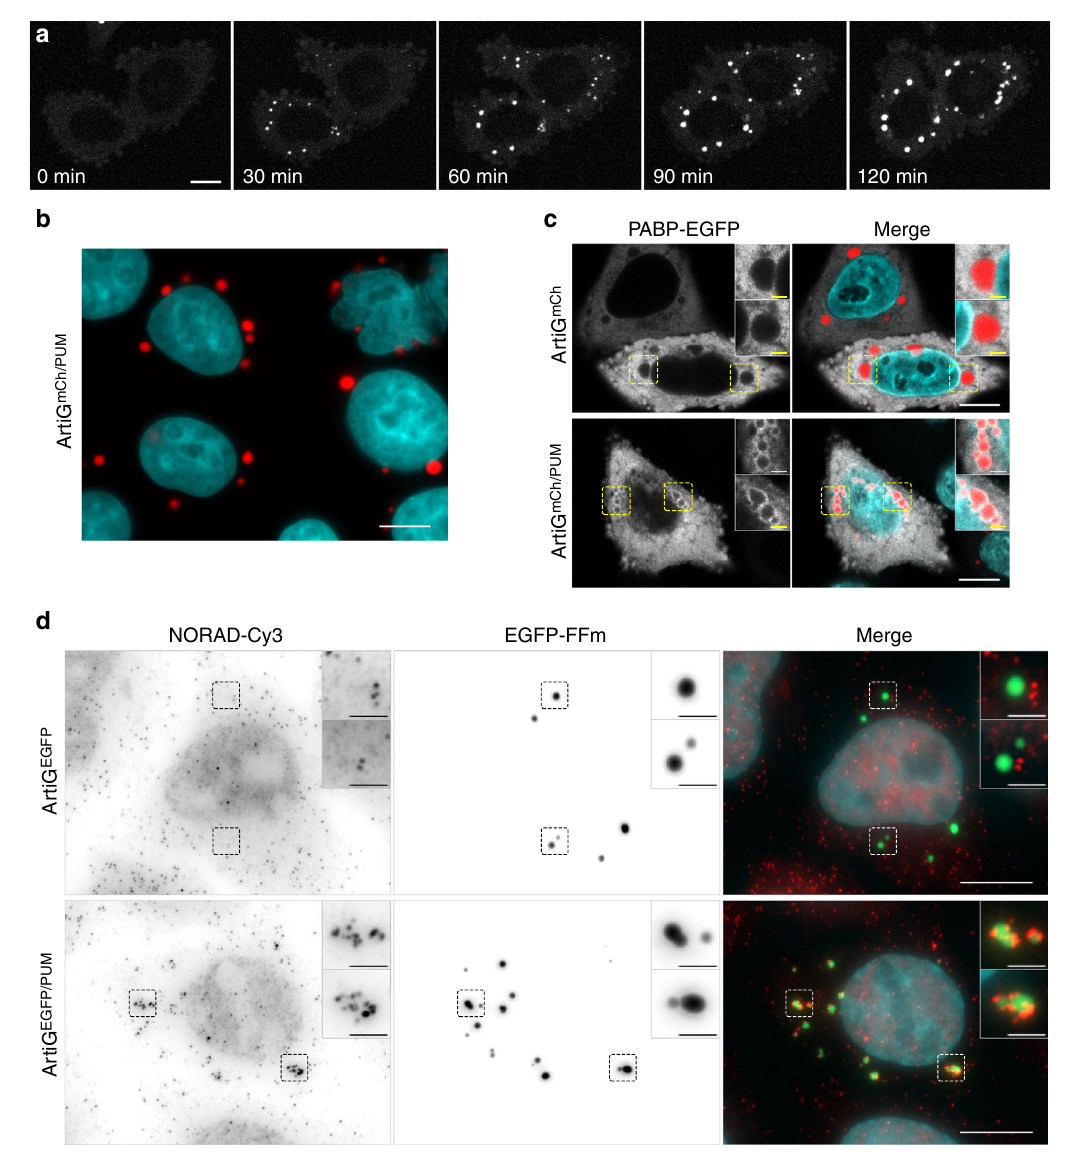
Fig. 3 ArtiG PUM recruit speci fi c endogenous RNAs. a Representative time-lapse confocal images of HeLa cells expressing mCherry-FFm and PUM.HD-FFm constructs. Scale bar, 10 µ m. For the purpose of representation, the images are slightly saturated. b Representative confocal image of ArtiG mCh/PUM (red) in HeLa cells, 24 h after transfection of mCherry-FFm and PUM.HD-FFm constructs. Nuclei were stained with Hoechst (blue). Scale bar, 10 µ m. c To visualize polyadenylated RNA, a PABP-EGFP fusion (white) was co-transfected with mCherry-FFm and PUM.HD-FFm (red) into HeLa cells 24 h before fi xation. Confocal imaging. Scale bar, 10 µ m. Zoom, 2 µ m. d Epi fl uorescence imaging of NORAD lncRNA following smFISH-Cy3 (red in merge) in HeLa cells expressing ArtiG EGFP (green in merge, upper row) and ArtiG EGFP/PUM (green in merge, lower row). Nuclei were stained with DAPI (blue). Scale bar, 10 µ m. Zoom, 2 µ